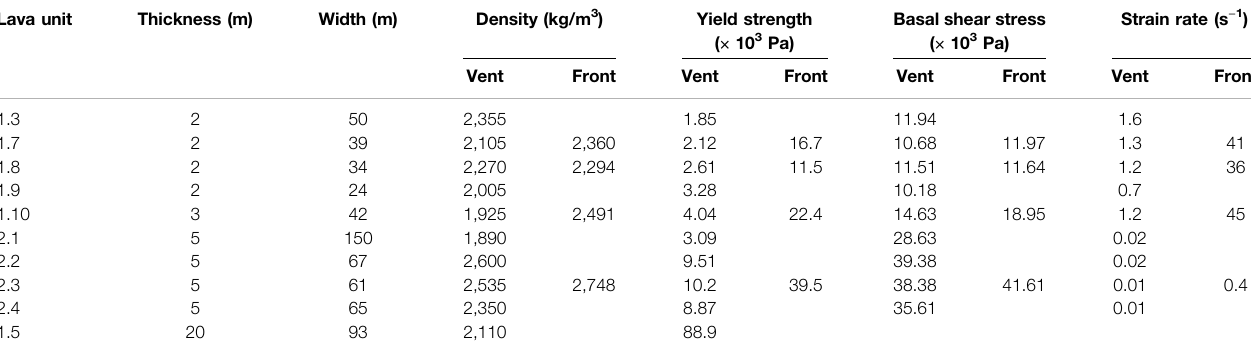
TABLE 6| Yieldstrengths, basalshearstressand strainratecalculatedforPhaseIand IIunits forwhichwehave densityvalues( Table3 ).Forthebasalshearstress, weuse slopesof15 ° forPhaseIand18 ° forPhaseII,andforstrainrateweusethetypical(medianvalue)PhaseIandIImixtureviscositiesof Table5 .Unit1.5isplacedlastasitus somewhat anomalous amongst the Phase I units, and a basal shear stress and strain rate could not be